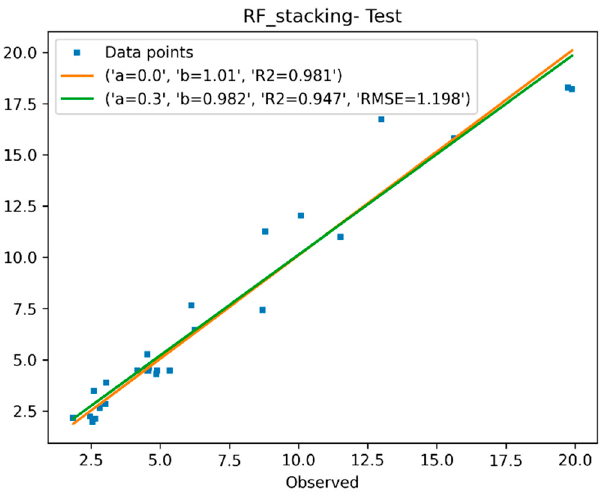
Figure 9. QSPR for the logarithm values of equilibrium constants for Eu 3+ complexation: observed vs. predicted affinity constant logarithms (LogK) of Eu 3+ complexation for the test set while using the RF-stacking model.